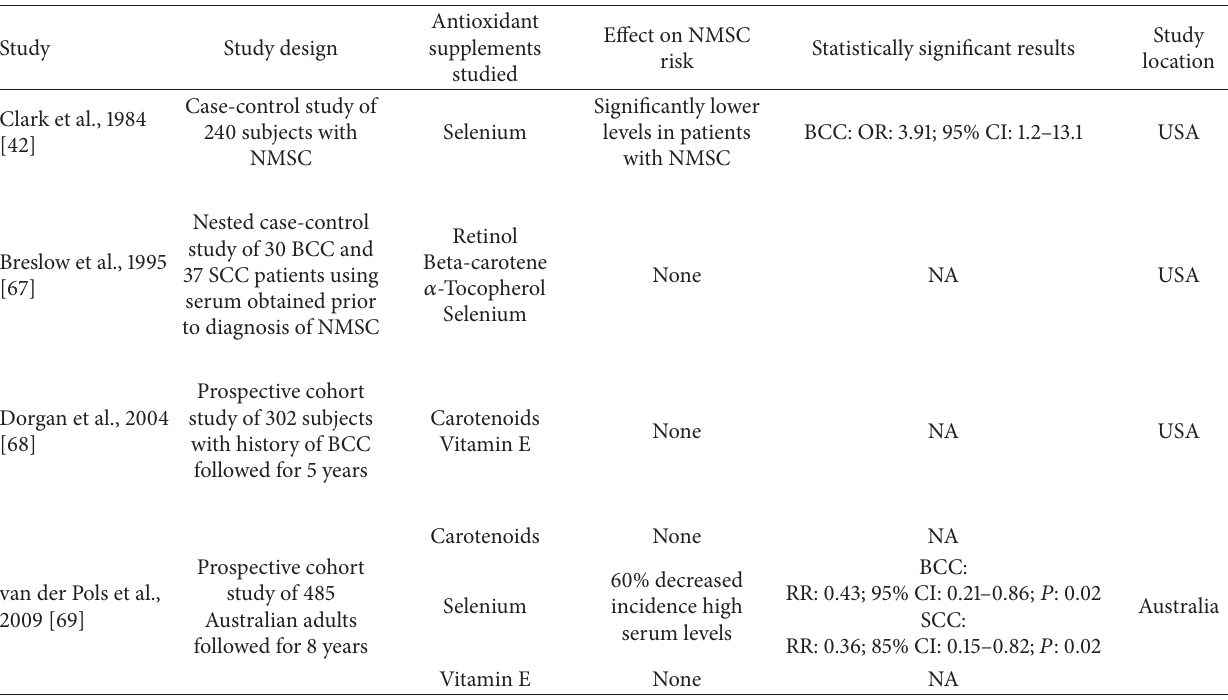
Table 3: Serum AO levels and NMSC